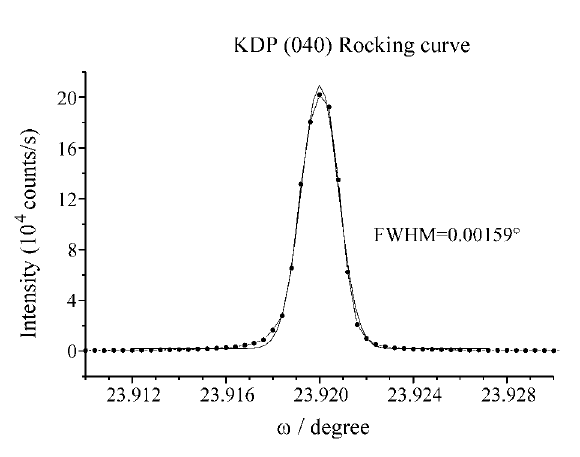
Figure 1. Rocking curve obtained at XRD station of the LNLS. The experimental points are presented with the gaussian fitting just to provide a better